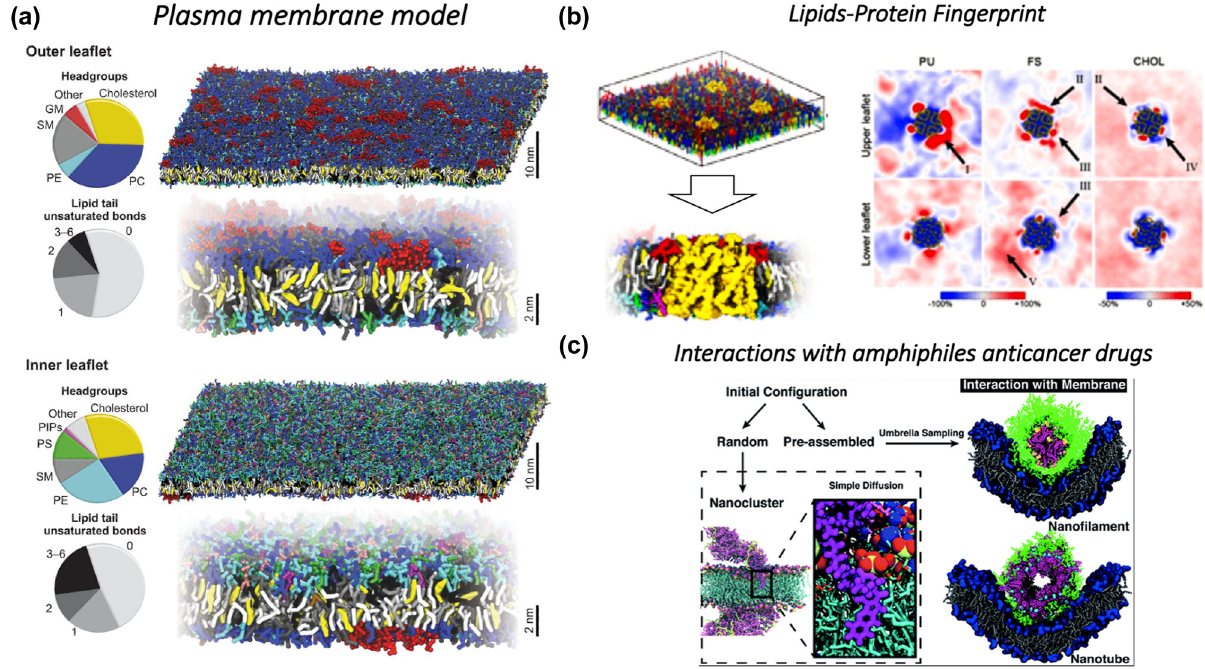
Figure 4: Realistic cellular membrane modeling. ( a ) Modeling of an idealized plasma membrane. The model of plasma membrane comprises 63 di ff erent lipid types, including cholesterol, phosphatidylcholines ( PC ) , sphingomyelins ( SM ) , phosphatidylethanolamines ( PE ) , gang - liosides ( GM ) , phosphatidylserines ( PS ) , and phosphatidylinositol phosphates ( PIPs ) . The overall headgroups composition and number